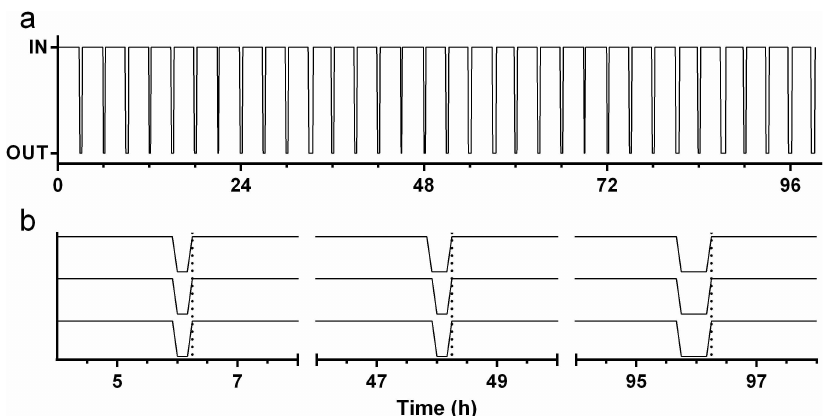
Fig 4. In vitro evaluation of adherence IVR. Response of adherence IVR over 100 h using a simulated insertion/removal cycle of 2.5 h in and 0.5 h out (lower plot) using a programmed temperaturetest apparatus. Data represent the IN/OUT status (0 or 1) loggedat a 5 min interval. The upper plot shows expansionof data at 6, 48, and, 96 h for three adherenceIVRs measuring simultaneously. Vertical dotted lines indicatetransition to “IN” temperature for each cycle shown. The temporalalignmentof “IN” measurements does not vary betweenthe three devicesover 96 h of measurement. The time requiredfor the device to respondto a simulatedinsertion or removalevent was determinedusing the temperature-time data shown in Fig 5. The device was exposedto three repeatedstep changesin temperature between28˚C and 37˚C, and response was calculatedas the time requiredfor the device to measurethe range of 10% to 90% of the total 9˚C temperature change (28.9˚C and 36.1˚C). For the step from 28˚C to 37˚C (simulatedinsertion), the 10%-90% time was 1.84 ± 0.006 min. For the step from 37˚C to 28˚C (simulatedremoval), the 90% to 10% time was 1.96 ± 0.096 min.